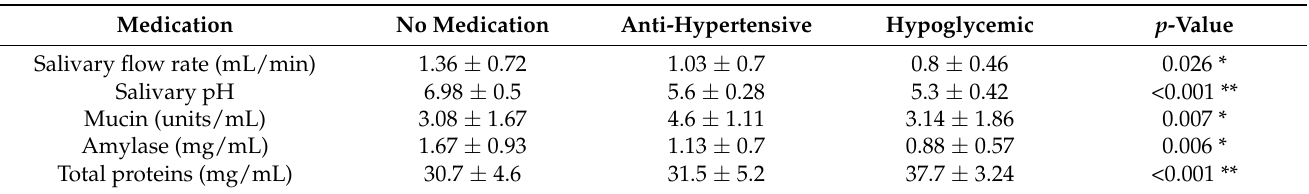
Table 3. Effect of anti-hypertensive and hypoglycemic drugs on salivary flow rate, salivary pH, levels of mucin, amylase, and total protein